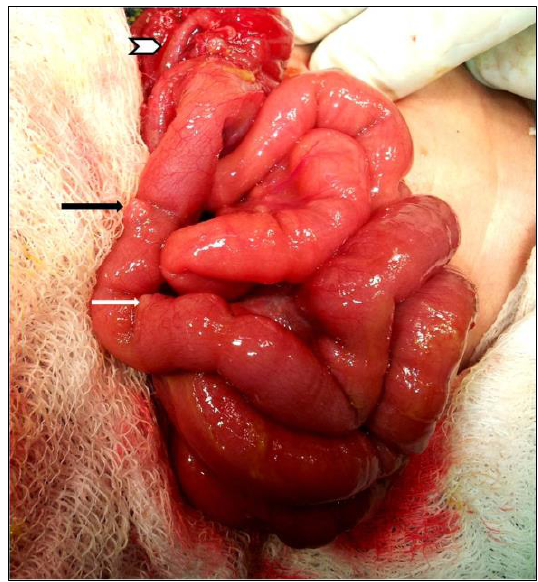
Figure 1: Operative photograph showing the two Meckel’s diverticulae (arrows) and the long appendix